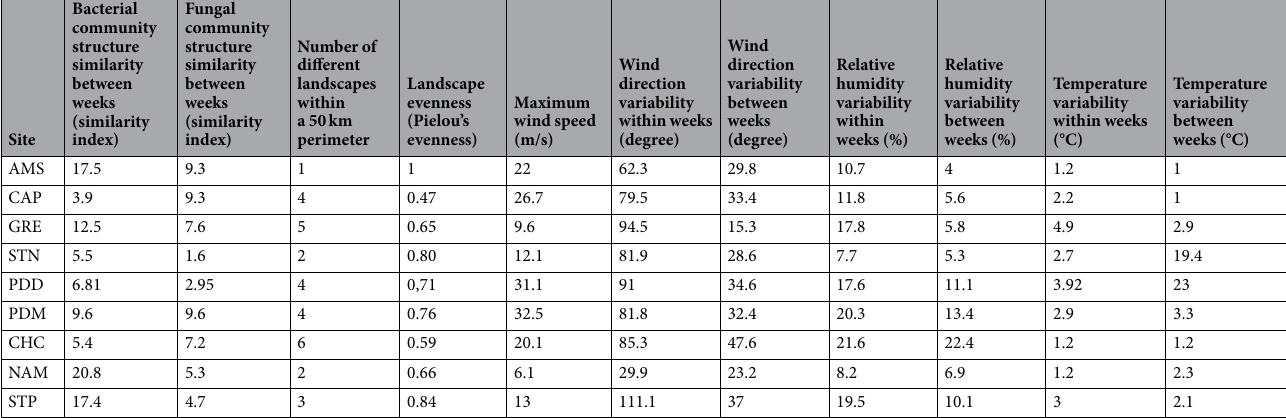
PM10 chemistry correlated to both the bacterial ( R = 0.79, P = 0.007) and fungal ( R = 0.68, P = 0.02) community structures over all the sites, the correlation was considerably less for the terrestrial sites for bacteria ( R = 0.16, P = 0.33) and fungi ( R = 0.51, P = 0.03). The strong correlation observed when considering all the sites might be more indicative of strong differences between the different ecosystems (marine, polar, coastal and terrestrial) in terms of chemistry and microbial communities than a similar behavior and/or driving processes of the PM10 and microbial cell distribution. This weak correlation between PM10 chemistry and airborne bacterial communities over the terrestrial sites has been observed previously 1,18 , but certain chemicals might affect specific microbial populations without influ- encing the overall correlation. For example, methylsulfonic acid (MSA) was correlated to the genus Acholeplasma ( R = 0.88, P = 1.7 × 10 − 3 ). Certain polyol concentrations were correlated to the relative abundance of specific fungi ( e.g ., mannitol-arabitol and the species Zalerion arboricola R = 0.85, P = 3.9 × 10 − 3 ). Polyols can be major components of fungal biomass and have been proposed as a suitable marker for fungal spores 50 . We currently do not know whether these chemistry-microbial genera/species correlations are due to similar sources for both PM10 and microorganisms or that the chemistry is selecting for these microorganisms during atmospheric transportation. The similarity of the sites based on the PM10 chemistry globally matched the similarity of the sites based on the characteristics of the landscapes surrounding the sites (Fig. 4). However, since the correlation between the chemistry and the characteristics of the surrounding area was not very high when considering only the terrestrial sites ( R = 0.32, P = 0.1), distant sources and/or photochemical transformations (formation of secondary aerosols) likely also contribute to the PM10 chemistry distribution. A strong correlation was observed between both air- borne bacterial ( R = 0.80, P = 0.001 with all the sites; R = 0.65, P = 0.004 with only the terrestrial sites) and fungal community structure ( R = 0.64, P = 0.003 with all the sites; R = 0.47, P = 0.05 with only the terrestrial sites) and the landscapes (Fig. 4 and Supplementary Fig. S2). This correlation illustrates the important contribution of the local landscapes to the geographical distribution of airborne microorganisms. The landscapes with the most impact on the distribution of atmospheric microorganisms between the sites were ice, water, forest, grassland and cropland. These landscapes might emit distinct communities as compared to the others such as urban landscapes which did not seem to significantly contribute to the observed geographical microbial distribution of the sites. Regional environmental factors, and specifically, a combination of climate and soil characteristics (but no effect from urbanization) have been reported to correlate to the geographical distribution of dust-associated microbial communities 10 . Reports of other smaller-scale studies 2,13,16,18 suggested a strong influence of the local sources in the spatial distribution of airborne microbial communities. Airborne microbial community structure at the coastal site Cape-Point was more similar to that for terrestrial sites than those from marine or polar sites. This might reflect that terrestrial landscapes contribute more biomass to airborne microbial communities than oceanic landscapes, as was proposed by Burrows et al., (2009) 40,41 . Our airborne bacterial concentrations were mainly correlated to the surrounding landscape. We observed the highest atmospheric bacterial concentrations at the grassland sites (Namco, Storm-Peak) and urban and cropland sites (Grenoble, Puy-de-Dôme), followed by the coastal site (Cape-Point), marine site (Amsterdam-Island) and polar site (Station-Nord). We did not observe the highest average concentration of bacteria at the most urban site (Grenoble) as expected based on the study of Burrows et al., (2009) 40,41 , although Grenoble might not be as indus- trial as others reported in the literature 1,11 . Instead, the highest average concentration of bacteria was observed at Namco, which is a remote high-altitude and semi-arid grassland site (grassland covers > 80% of the surrounding landscape over 50 km of diameter). Pic-du-Midi (cropland/vegetation) and Chacaltaya (grassland), which are two high-altitude mountain peaks, had relatively low average bacterial concentrations that were comparable to